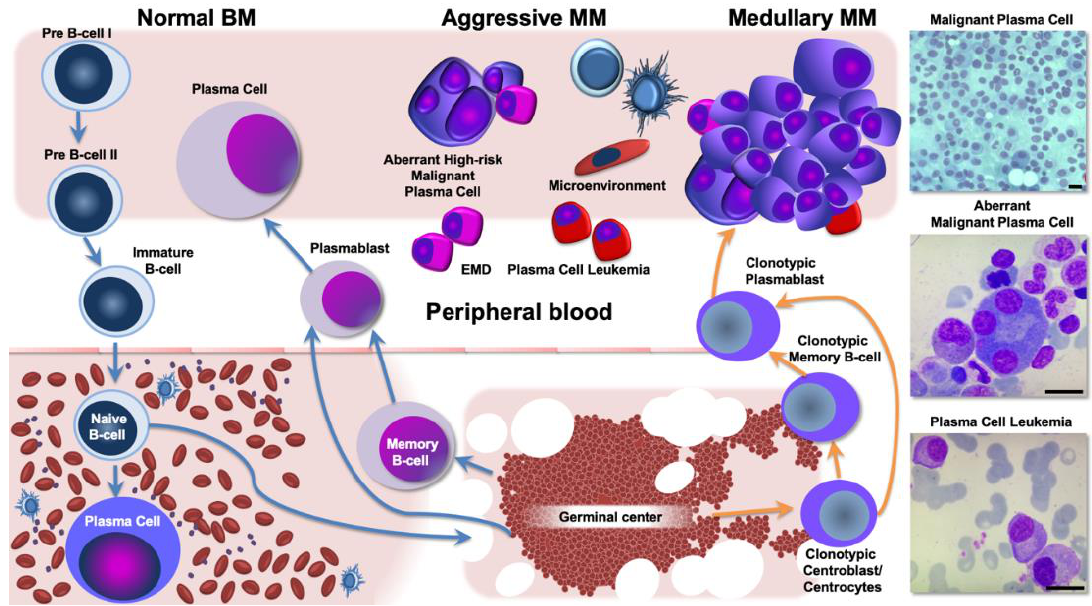
Figure 2. B-cell differentiation, multiple myeloma (MM) development, and aggressive disease phenotypes. Left panel: pre-B cells migrate from the bone marrow (BM) into the peripheral blood and the germinal center. Memory B-cell differentiation drives the production and localization of plasma cells (PCs) into the BM. Right panel: The earliest clonotypic cell, putatively the MM precursor, can turn into mature premalignant PCs, namely MGUS. Subsequent genetic events lead to overt disease in multiple BM sites. Ultimately, clonal evolution driven by disease biology and BM microenvironment interaction continues to select MM PCs that finally give rise to extramedullary and aberrantly growing sub-clones. EMD: extramedullary disease.